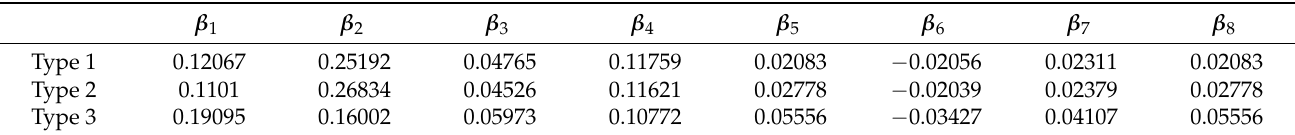
Table 2. Estimated coefficients for relationship between ECR and VSP for three types of